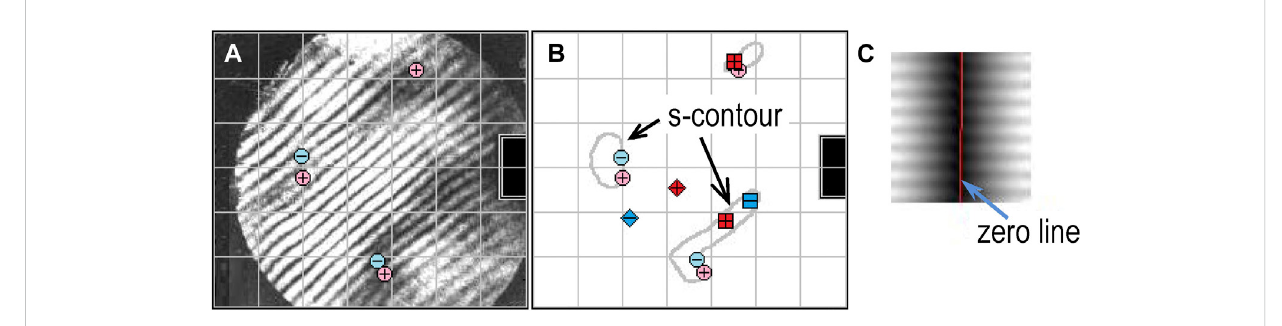
FIGURE 9 Experimental characterizationof C -points: (A) interferogram ofa certainplanar-polarization projection of avector fi eld with predominantly circular polarization; (B) reconstructed positions of C -points, s -contours, and vortices of the observed projection. Symbols , denote the right-handed C -points with right circular polarization. , mark the left-handed C -points. , denote the vortices of the polarization projection analyzed; “ +, − ” inside the square (circle) corresponds to the positive or negative TC of the C -point (vortex). (C) Interference pattern of the edge phase dislocation. Fringes on opposite sides of the dislocation line (red) are shifted by half a